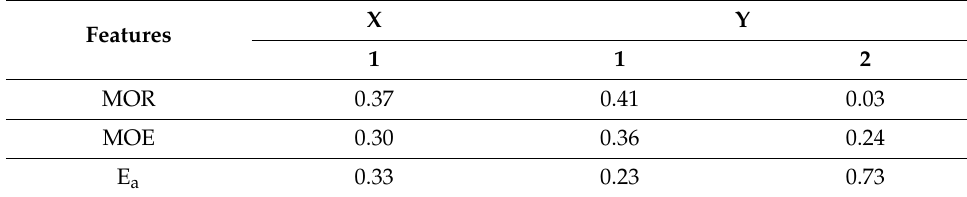
Table 5. Contribution of individual features to the principal components.